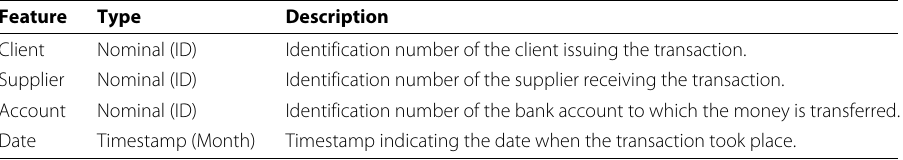
Table 1 Structure of the History data record. The History dataset is composed of 950,929 records collected from 6,063 companies over two